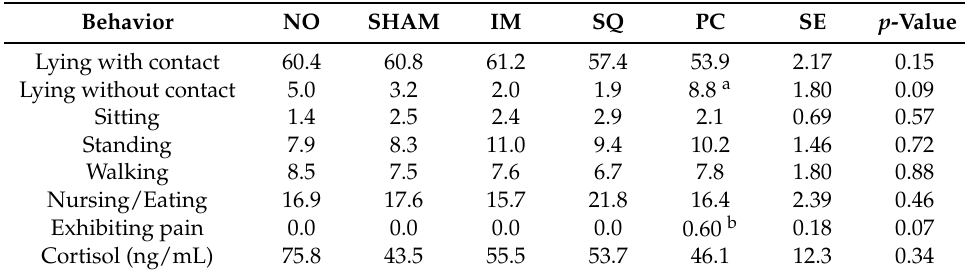
Table 1. Least squares means for percent of time piglets spent exhibiting behaviors for combined before and after treatment periods and cortisol concentrations for the 1 h after treatment period. Periods (PER) were divided into 1 h before treatment and 1 h after treatment. Treatments (TRT) applied at 3 to 5 d of age: no handling or treatment (NO), intramuscular (IM) injection, subcutaneous (SQ) injection, nothing, SHAM handling or physically castrated (PC). N = 50 piglet